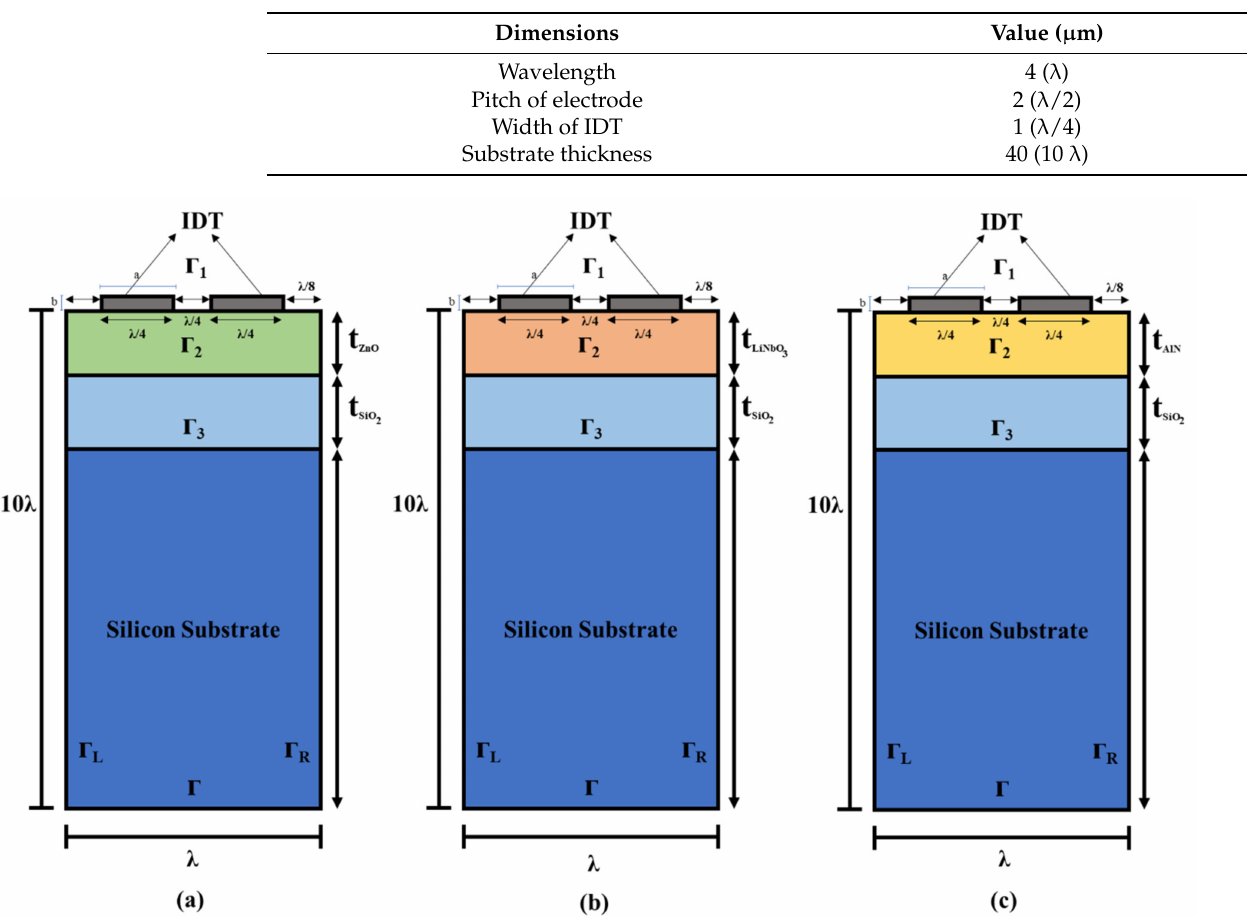
Table 1. Dimensions of the device.